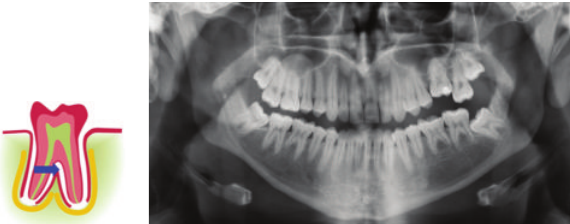
Figure 11: Drawing and panoramic radiograph (of a 20-year-old female) showing secondary retention of a permanent first molar in the left side of the maxilla. This first molar erupted normally, but ankylosed in the periodontal membrane after eruption. Therefore, the tooth could not continue the eruption course by “continued eruption”asotherteethdountilgrowthendsafterpuberty.Anarrow indicates that the process often begins interradicularly. The cause of the ankylosis is